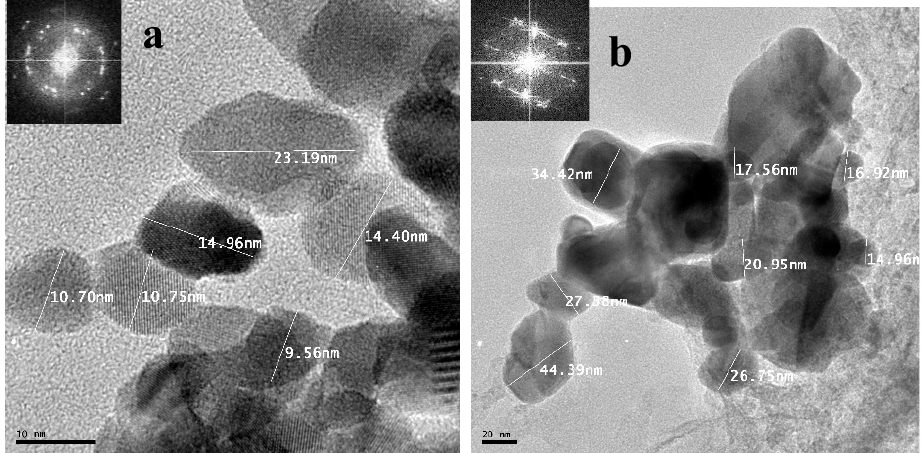
Figure 9. High-Resolution Transmission Electron Microscope (HRTEM) images of ( a ) SnS/HDA and ( b ) SnS nanoparticles.